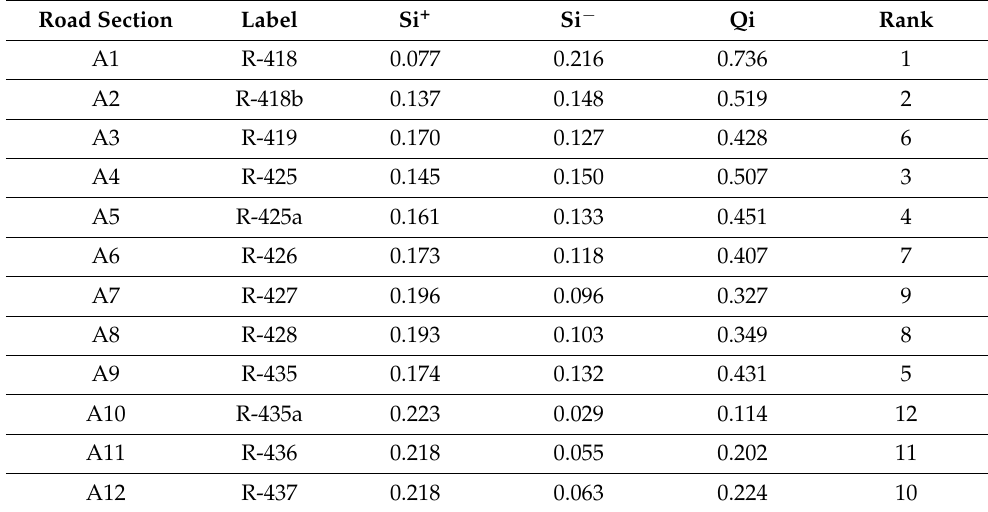
Table 7. Priority ranking of nonurban roads—Iteration